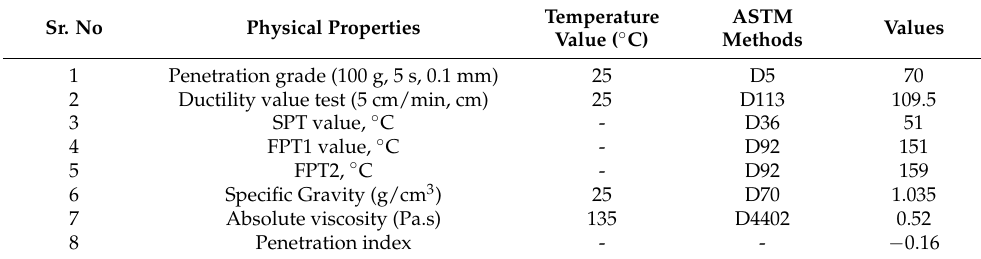
Table 1. The properties of PG 70 neat bituminous material.